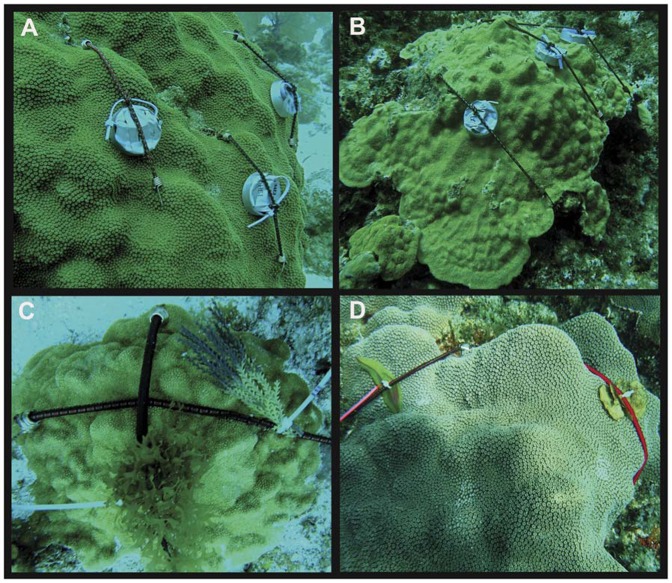
Photos of extract and algal application.Photos illustrate three experimental plates (shade control, solvent control, and macroalgal extract) on: A. M. faveolata and B. P. astreoides corals. Experimental application of C. Dictyota sp. foliose brown macroalgae and algal mimic to a P. astreoides coral colony in Belize (2009), and D. Lobophora variegata decumbant brown macroalgae and algal mimic to a M. faveolata coral colony in Belize (2009).